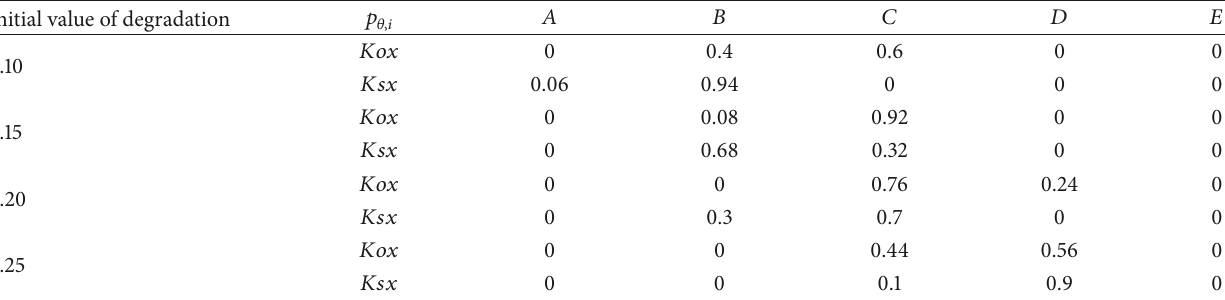
Table 6: Two pieces of independent evidence.